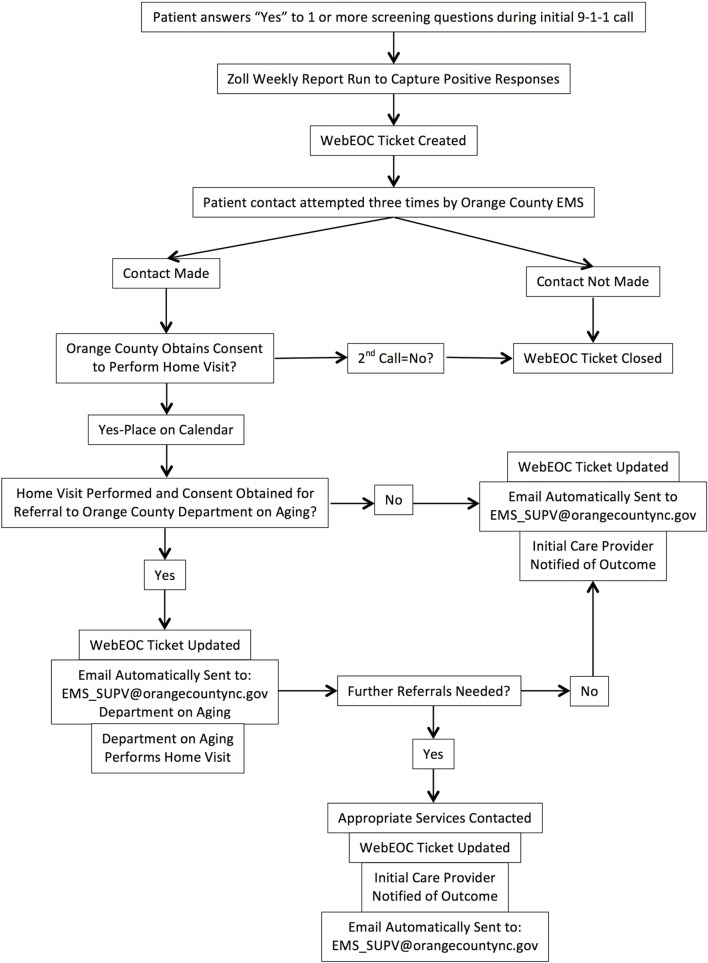
WebEOC flow chart.